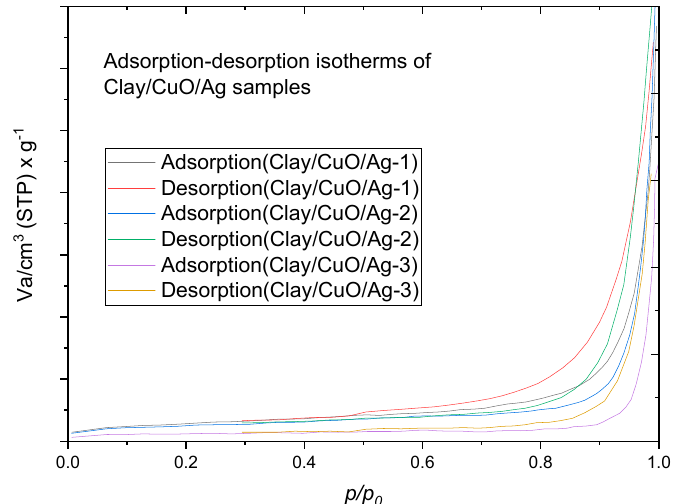
Figure 15. Adsorption-desorption isotherms of nitrogen gas at 77 K of “as-received” pellets of clay/CuO/Ag samples.